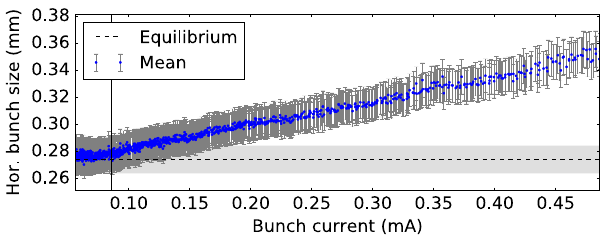
FIG. 3. Mean horizontal bunch size over bunch current. The dashed line and its grey error bar are depicting the simulated equilibrium bunch size at the VLD source point, while the vertical black line illustrates the calculated bursting threshold.